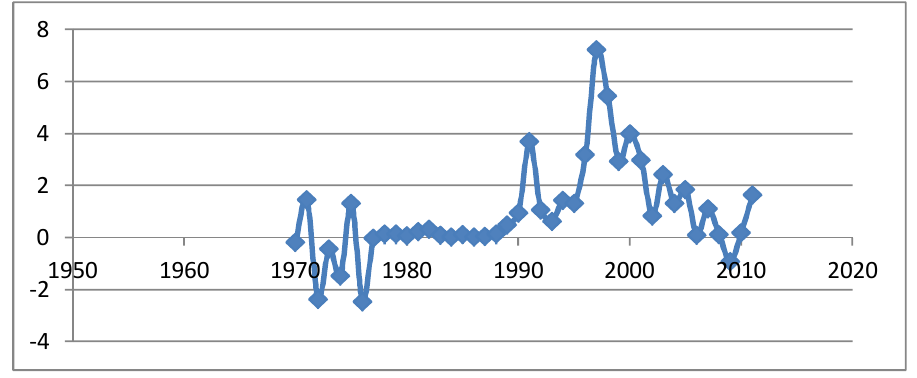
Figure 4: Net FDI (%gdp)